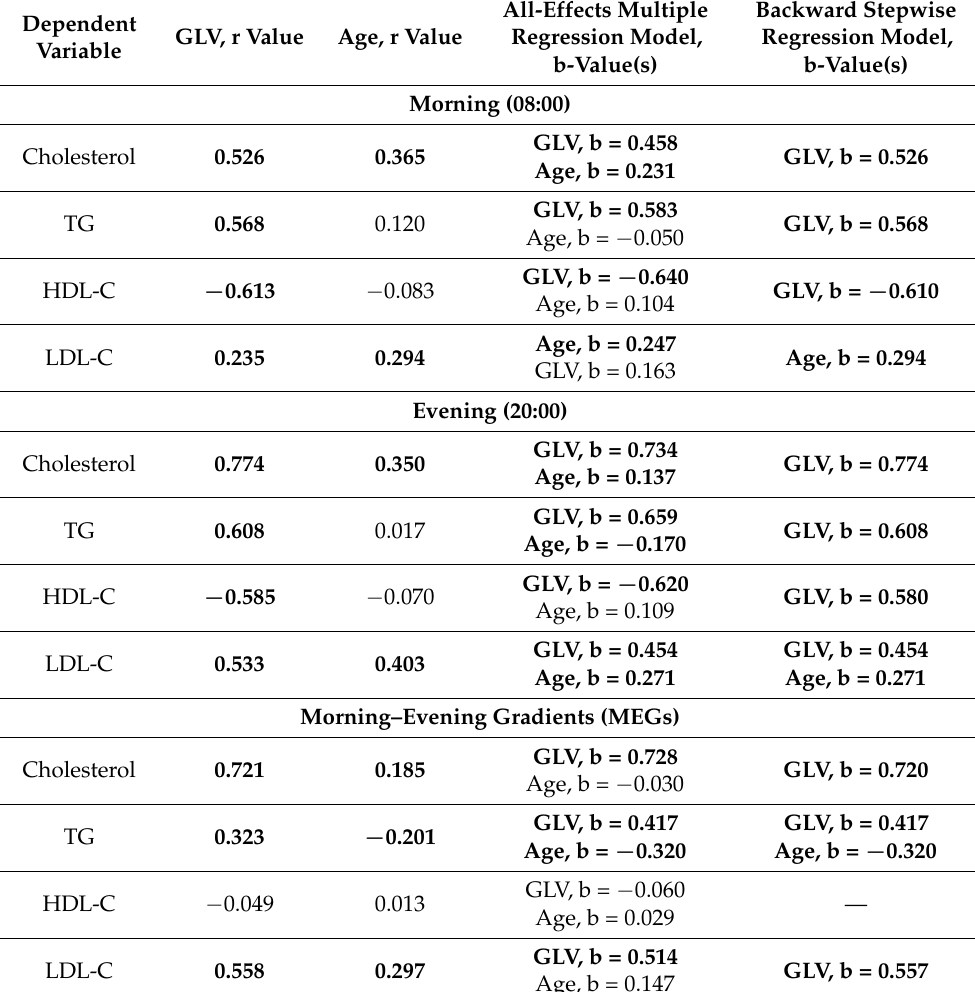
Table 1. Linear regression and multiple stepwise regression model of daytime lipids as a function of retinal ganglion cell damage and